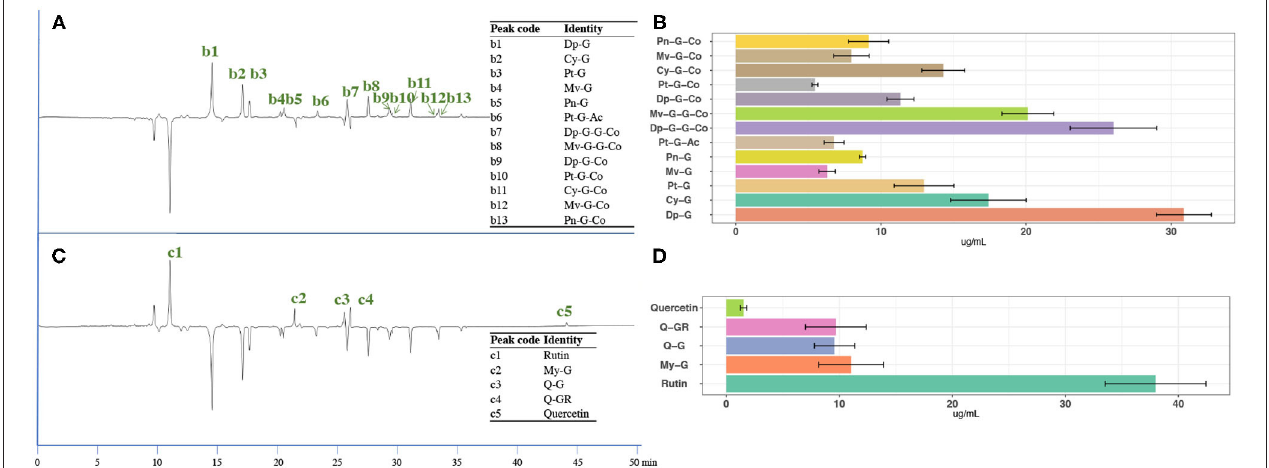
FIGURE 4 | (A) UV chromatographs of CGJ under 520nm and the tentative identification; (B) the content of detected anthocyanins in CGJ; (C) UV chromatographs of CGJ under 370nm and the tentative identification; and (D) the content of the detected flavonols in CGJ. Dp, delphinidin; Cy, cyanidin; Pt, petunidin; Mv, malvidin; Pn, peonidin; Pt, petunidin; My, myricetin; Q, quercetin; G, glucoside or other hexoside; Ac, acetyl; Co, coumaroyl; GR,